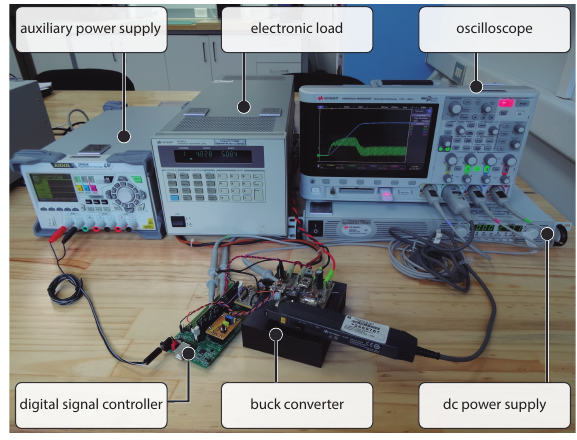
Figure 3. Picture of the experimental